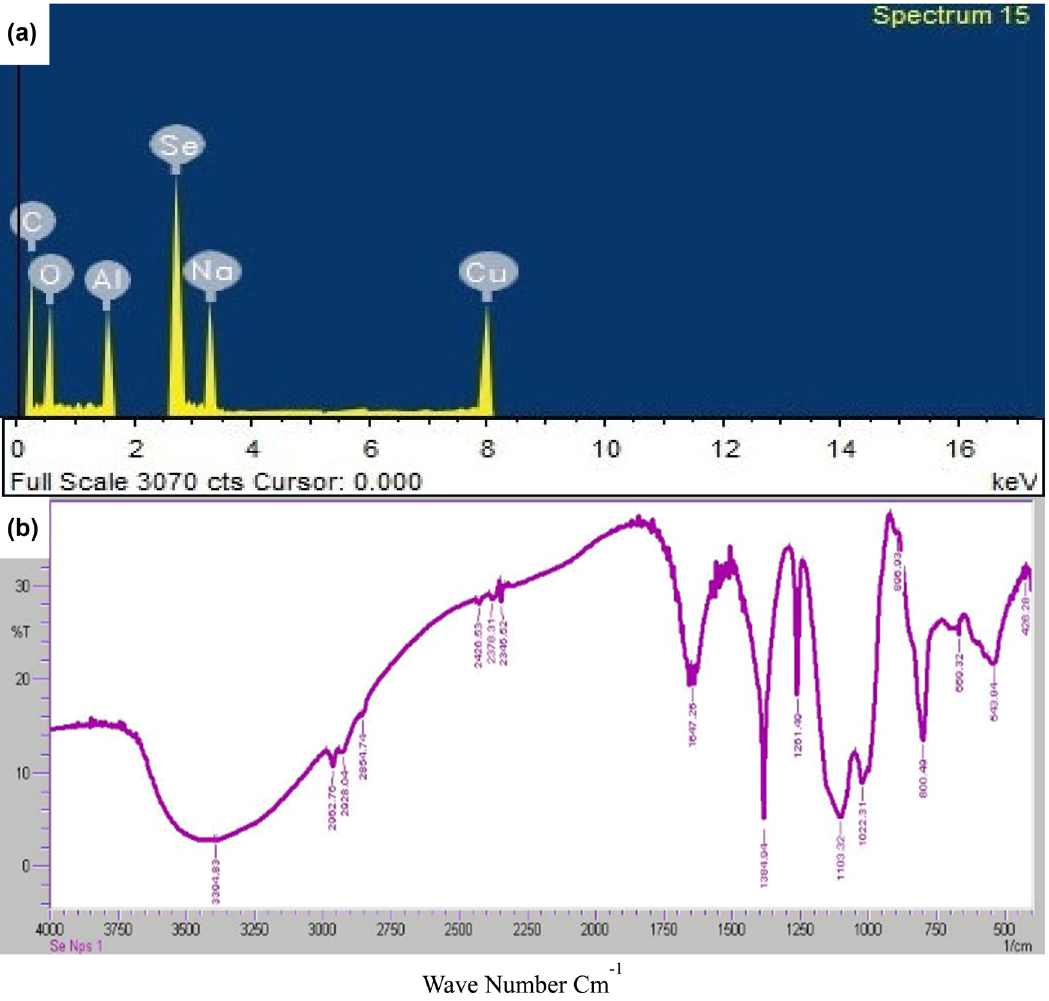
Figure 3: ( a ) Elemental composition analysis of SeNPs; ( b ) FTIR spectrum is showing di ff erent potential functional groups responsible to cap or stabilize